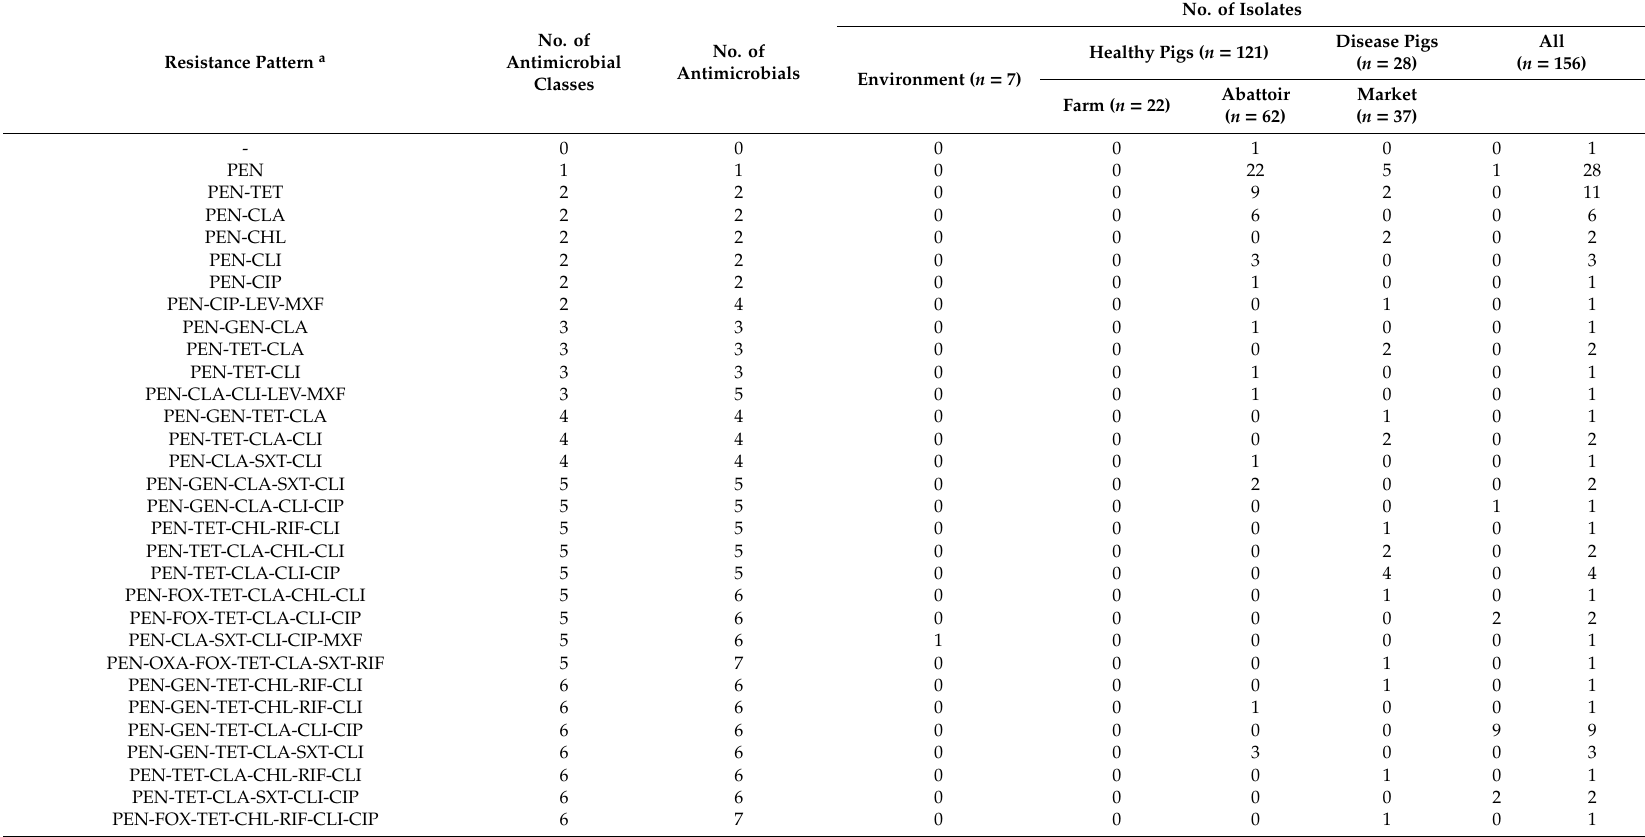
Table A2. Multidrug resistance patterns among 156 S. aureus